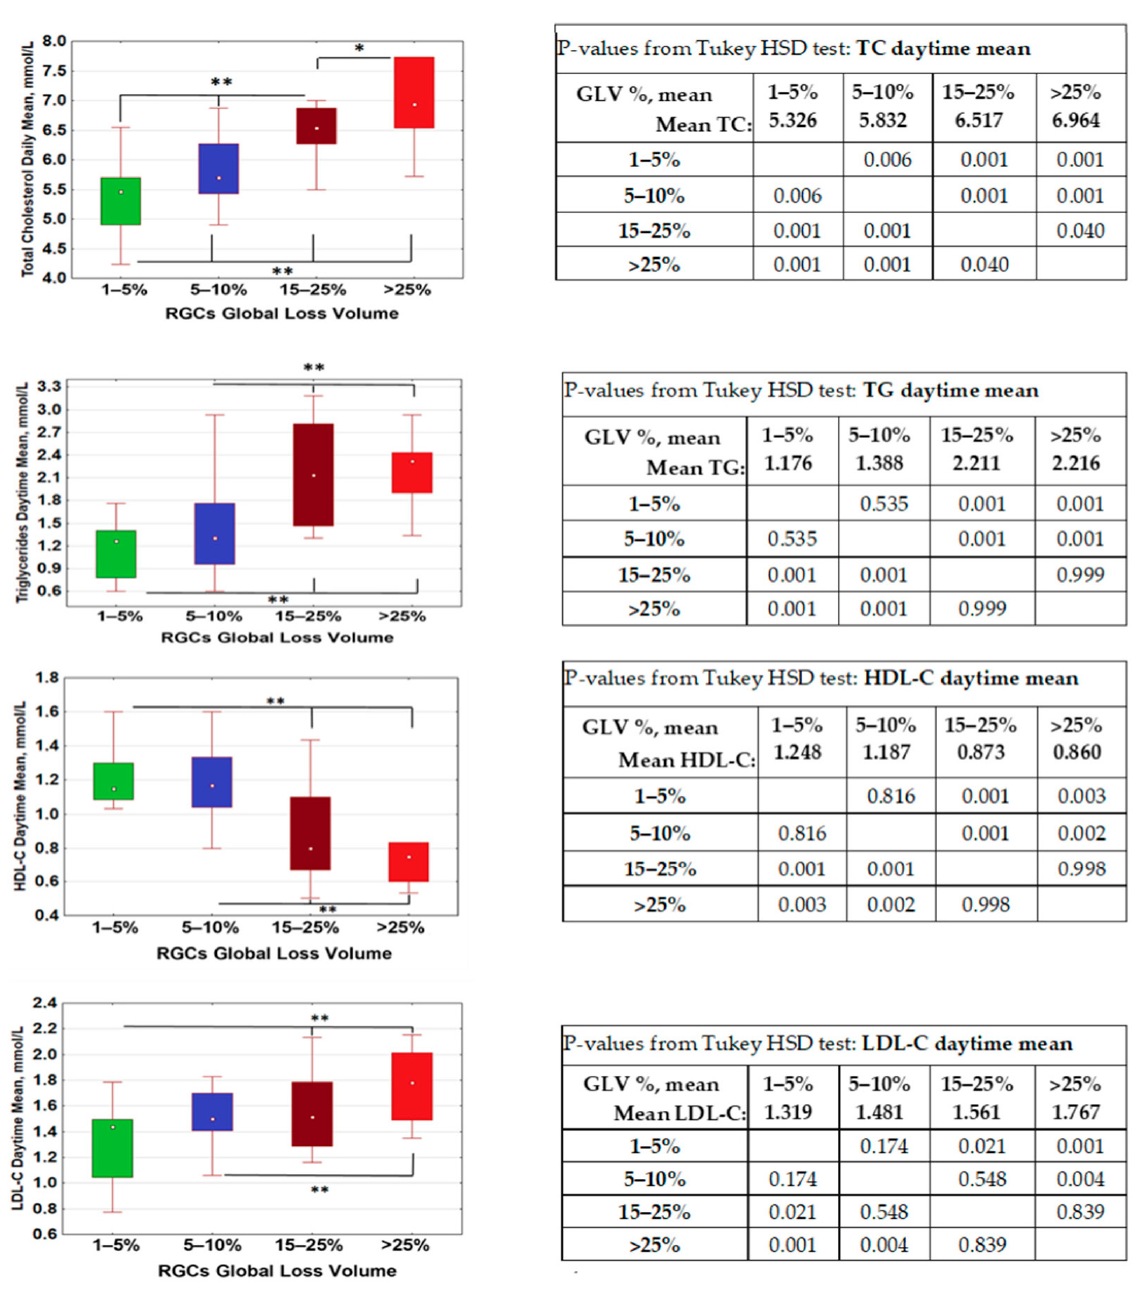
Figure 1. Daytime means of serum lipids in glaucoma patients with different degrees of retinal gan- glion cell (RGC) loss, assessed as two-eye mean global loss volume (GLV%), gauged by high-definition optical coherence tomography. n = 114; RGC GLV < 5%, n = 16; GLV = 5–10%, n = 49, GLV = 15–25%, n = 35; n > 25%, n = 14). Effects for daytime means: total cholesterol, TC: KW-H (3;114) = 54.923; p < 0.0001; triglycerides, TG: KW-H (3;114) = 47.120; p < 0.0001; HDL-C: KW-H (3;114) = 34.988; p < 0.0001; LDL-C: KW-H (3;114) = 12.762; p = 0.005. GLV%: two-eye mean RGC global loss volume. p -values for statistically significant difference between groups after Tukey’s honestly significant difference (HSD) test post-hoc are shown in red. **: p < 0.01; * p < 0.05.